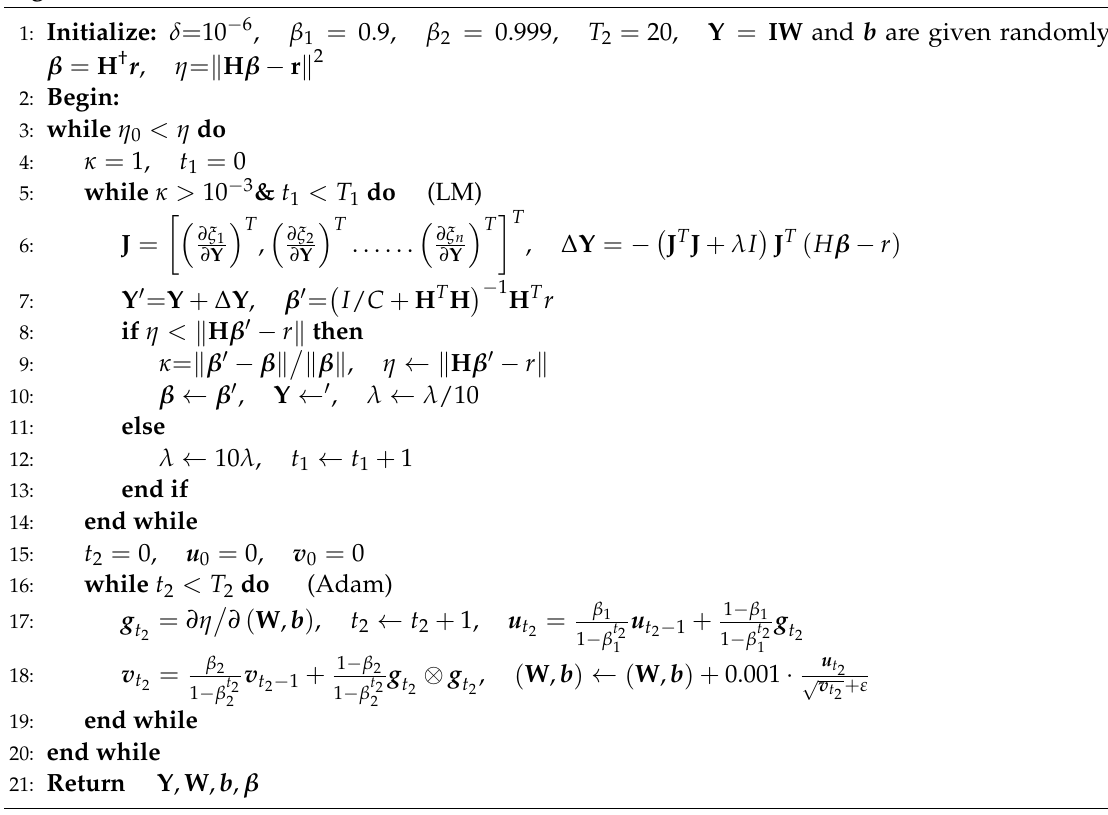
Algorithm 1 Switch from LM to